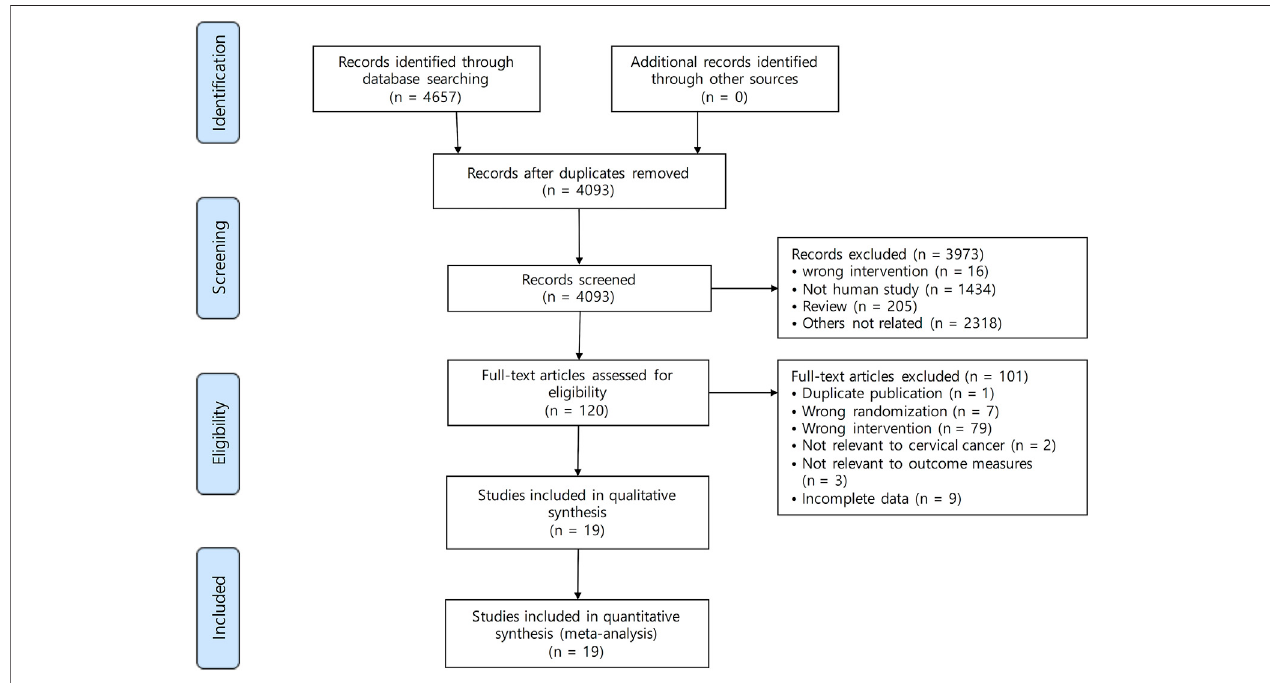
FIGURE 1 | Study fl ow